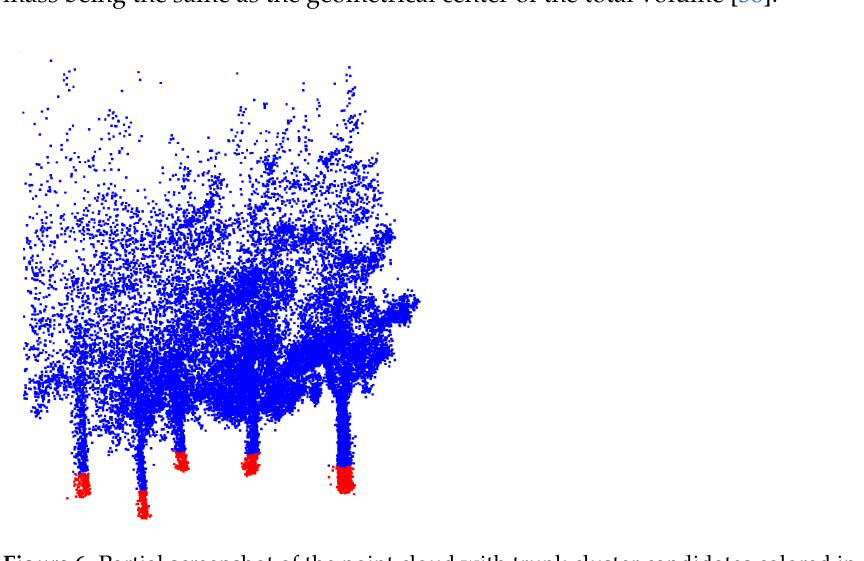
Figure 6. Partial screenshot of the point cloud with trunk cluster candidates colored in red.